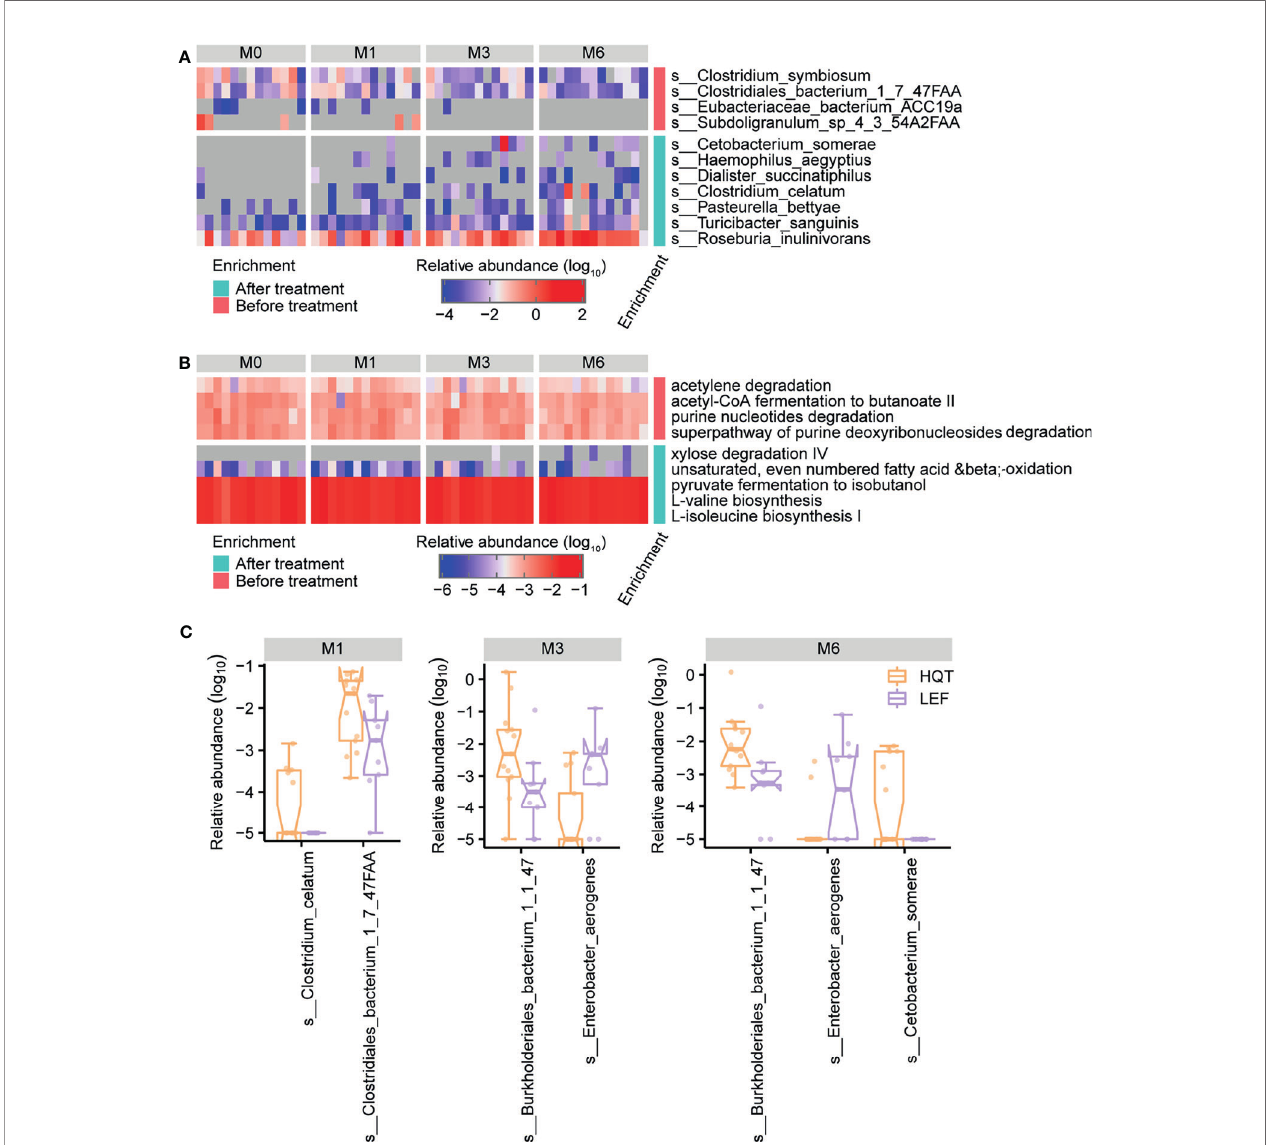
FIGURE 4 | Trends over time in gut microbial taxonomy and function after treatment with Huayu-Qiangshen-Tongbi (HQT) or le fl unomide (LEF). Signi fi cant changes in (A) species and (B) MetaCyc metabolic pathways in HQT group over time. P < 0.05 according to Jonckheere – Terpstra test. (C) Comparisons of relative abundance of various species at various time points between the HQT and LEF groups. P < 0.05 according to Wilcoxon rank-sum